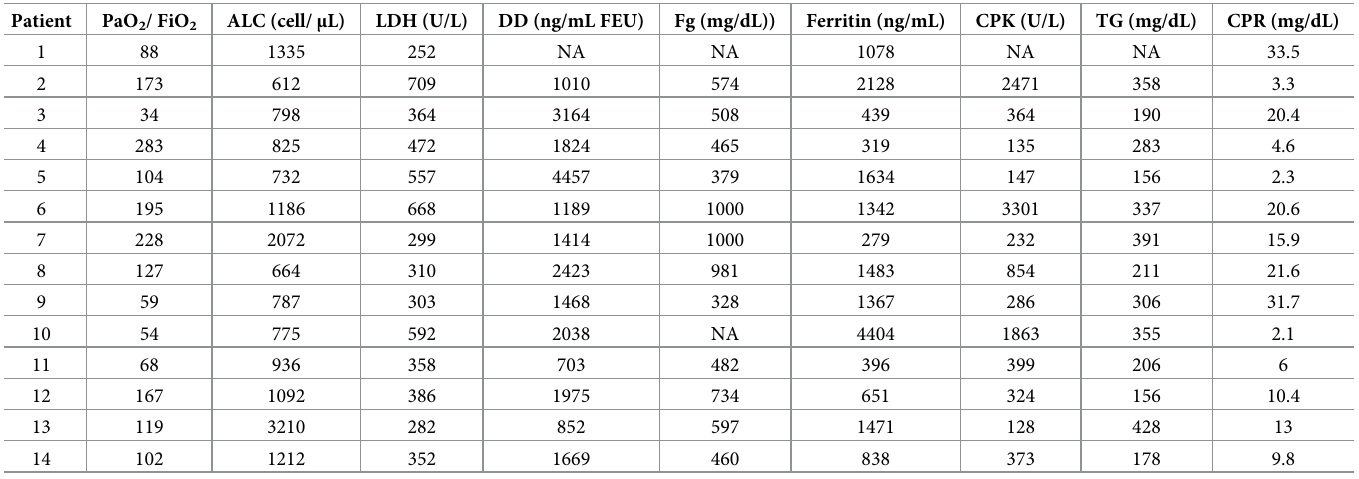
Baseline patient characteristics are described in Table 1 and the final (last values available before death) laboratory values and severity markers of COVID-19 in Tables 1 and 2. Lung pathology Thirteen lung biopsies were included in the analysis, tissue samples for one patient was not via- ble for tissue processing and analysis. In twelve (92%) of the cases, the histological examination revealed diffuse alveolar damage (DAD) in different stages of the disease (three on exudative phase, seven proliferative, two fibrotic), all of these samples had congestive capillaries, and Table 2. COVID-19 severity markers at time of